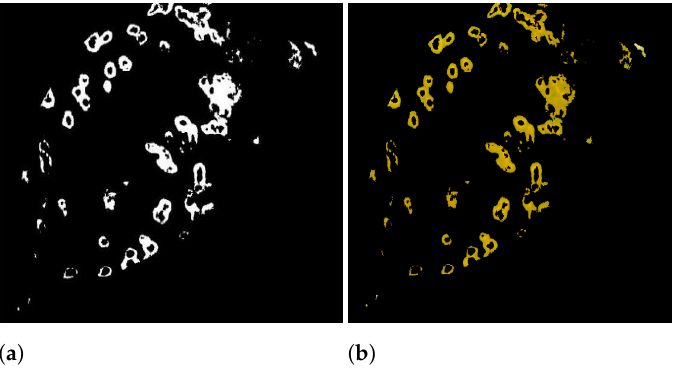
Figure 3. ( a ) Image in binary, ( b ) Segmented